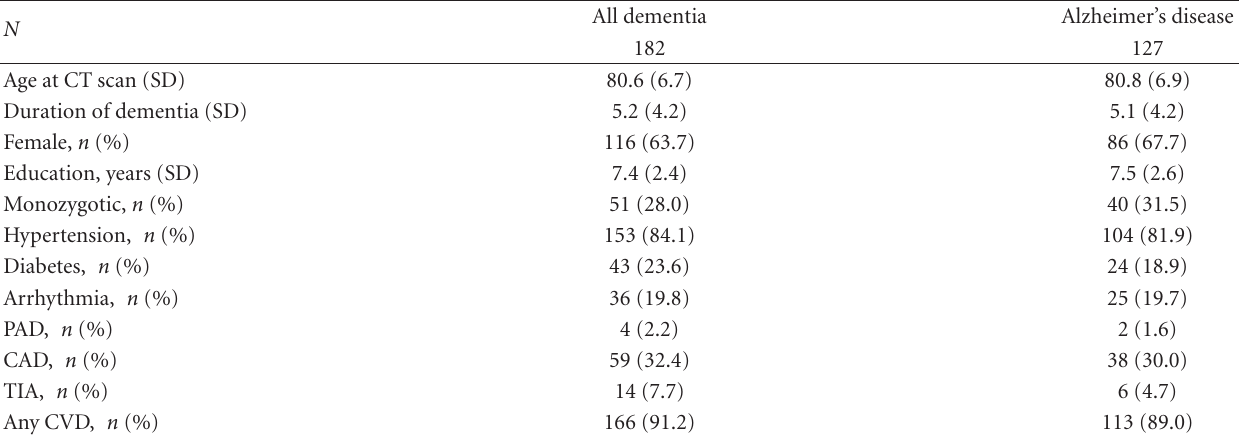
Table 1: Sample demographics and covariates for all dementia and alzheimer’s disease